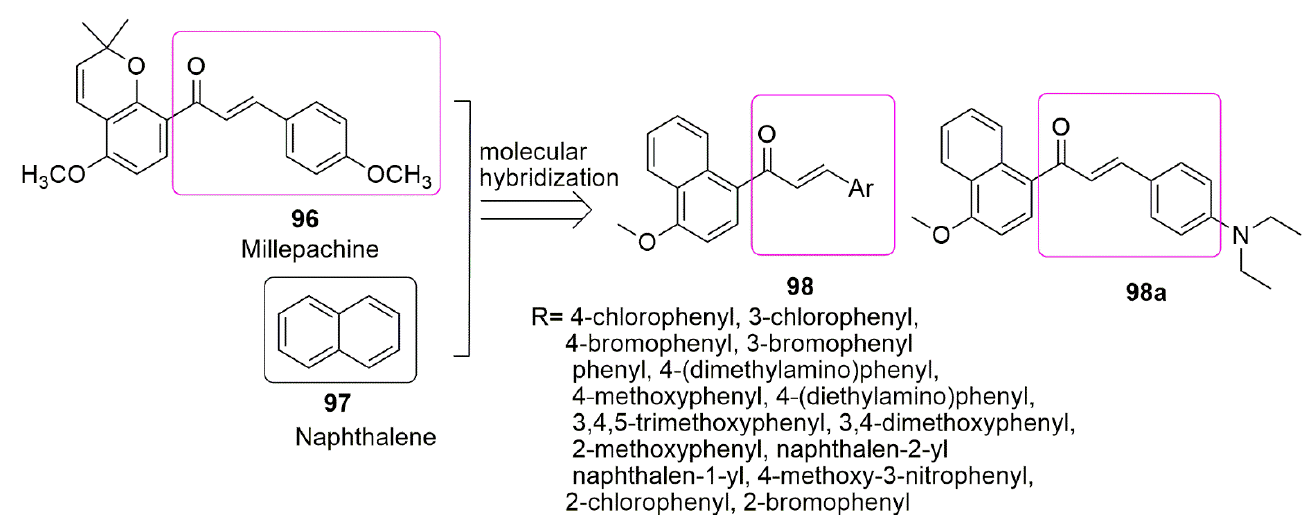
Figure 28. Molecular hybridization of chalcones and naphthalene moiety.